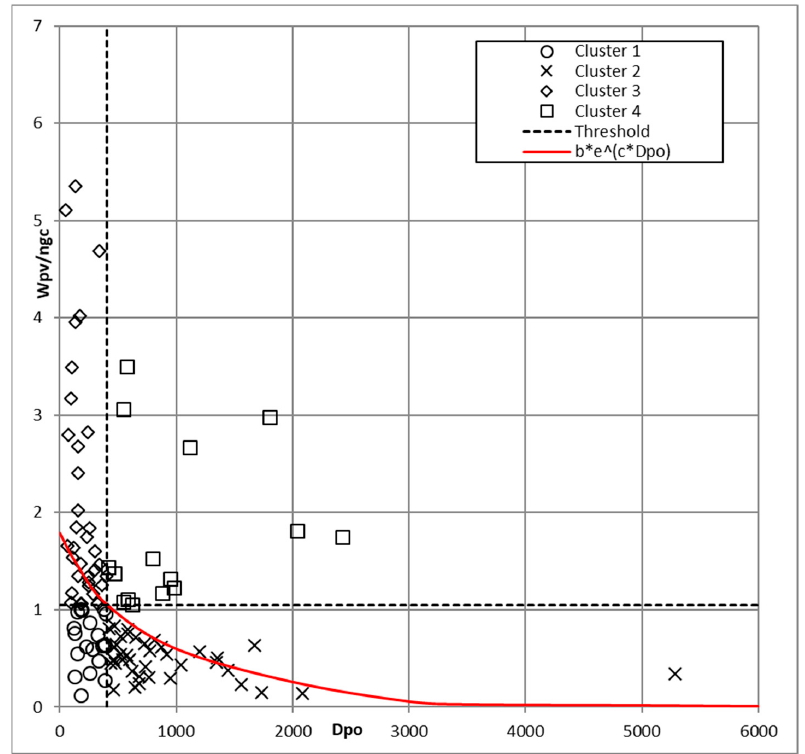
W PV versus D po versus D po . Figure 10. Plot of n gc (cid:3041) (cid:3282)(cid:3278)